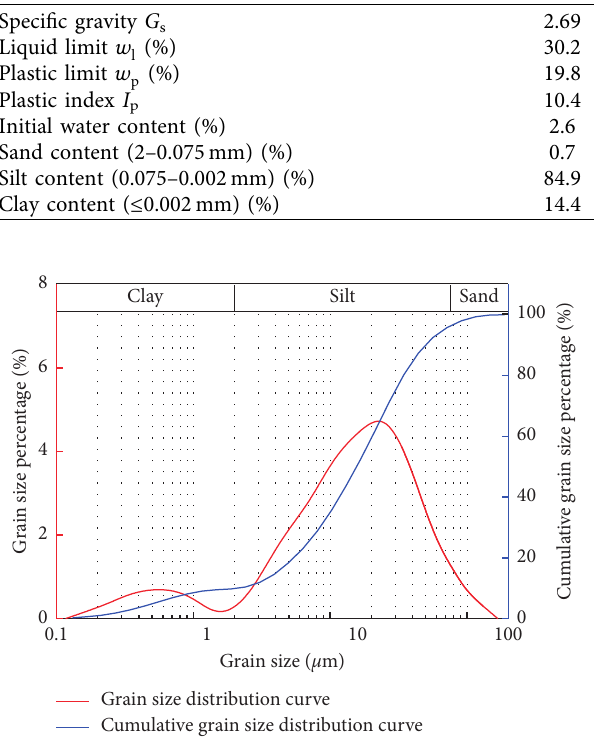
Figure 4: Grain size distributions of the tested